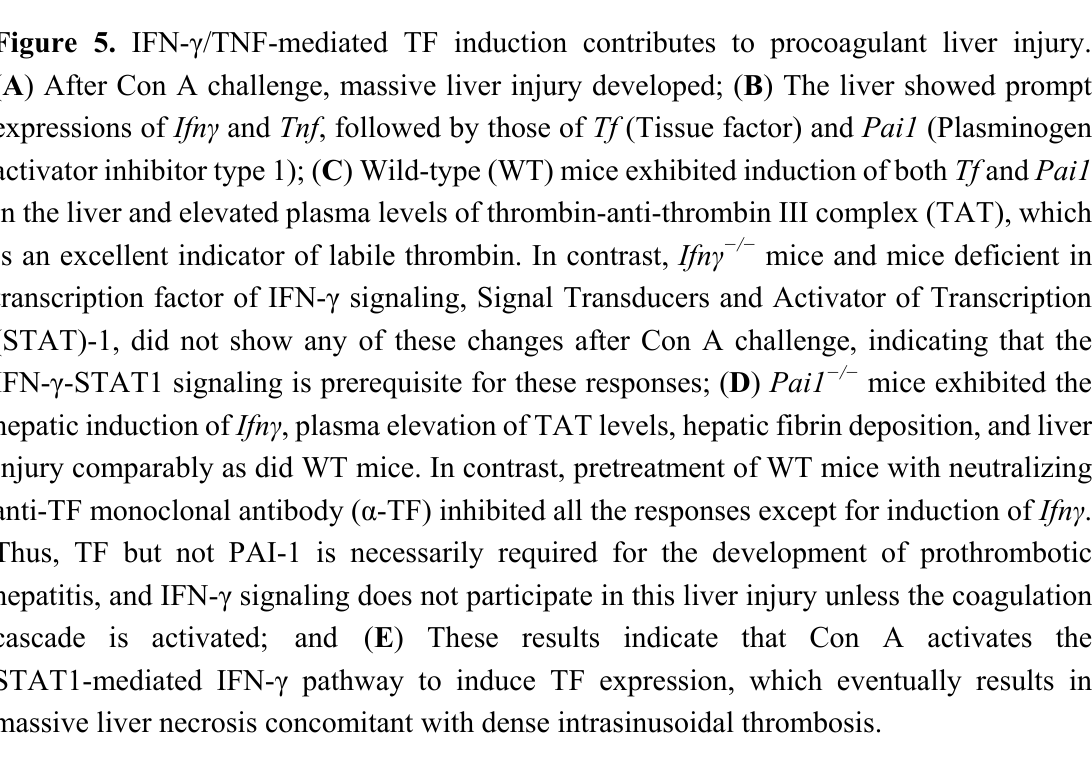
Figure 5. IFN- γ /TNF-mediated TF induction contributes to procoagulant liver